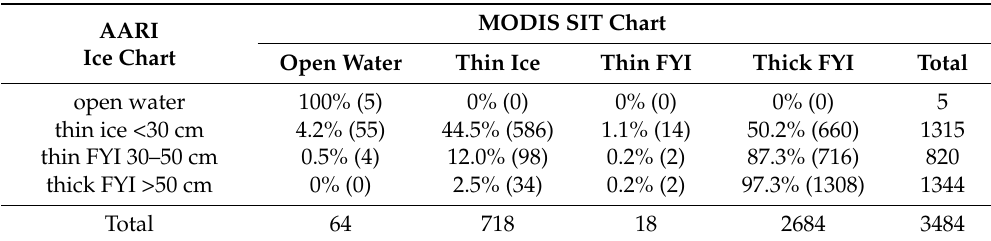
Table 2. Contingency table for the sea ice typing between the AARI ice chart and the MODIS ice chart within the AARI chart polygons. The comparison time period is November 2015 to April 2016. Numbers in brackets show the amount of